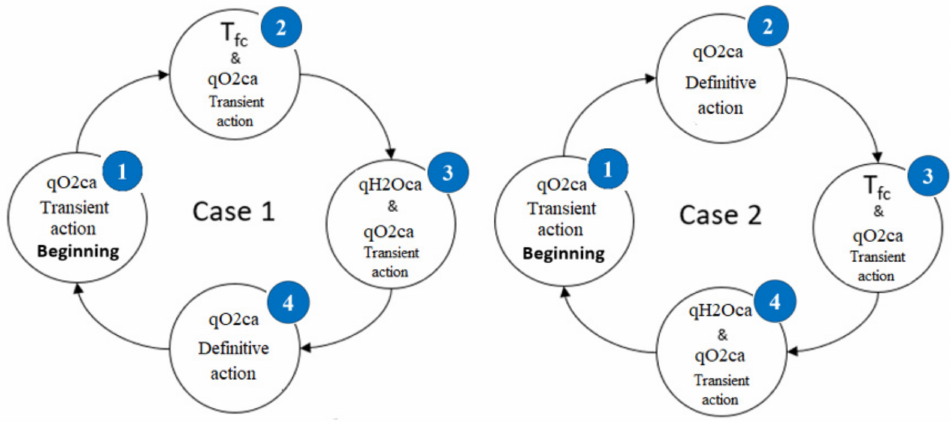
Figure 10. Two possible test cases for flooding